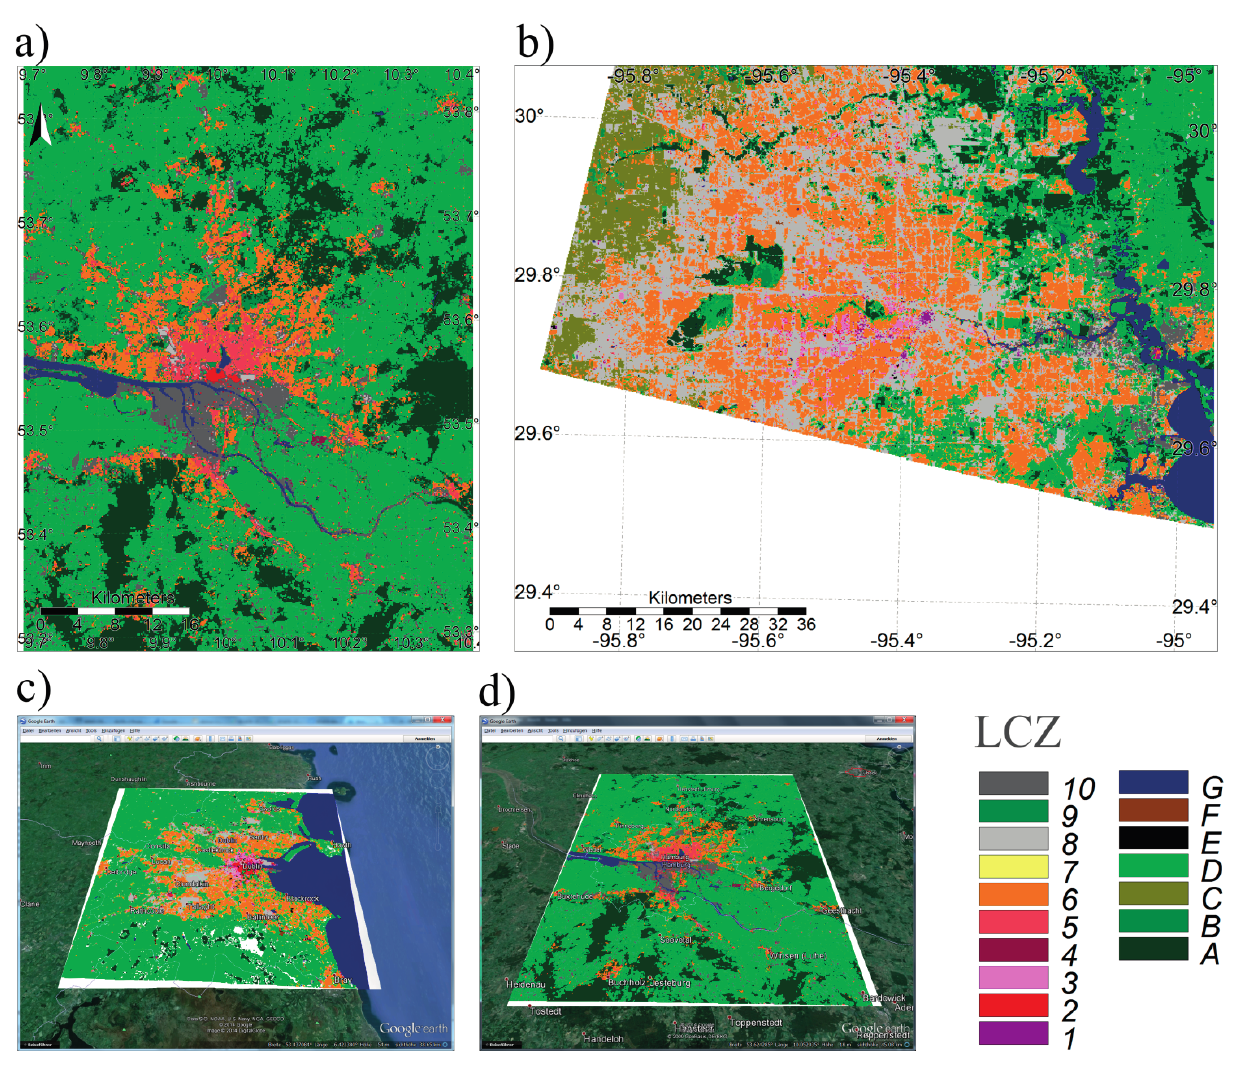
Figure 6. Local Climate Zones (LCZ) classification results for ( a ) Hamburg, Germany; ( b ) Houston, USA; ( c ) Dublin, Ireland in Google Earth; ( d ) Hamburg in Google